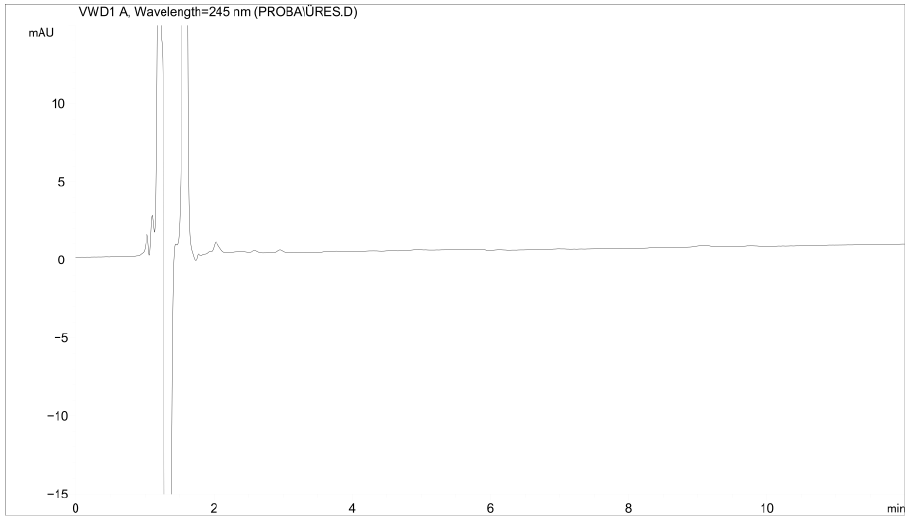
Figure A1. HPLC chromatogram of the blank small intestinal perfusate.